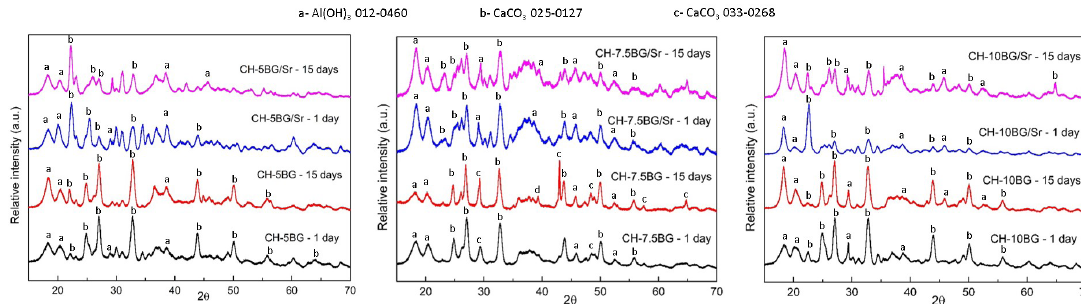
Figure 6. XRD patterns for blends based on homogeneous calcium aluminate cement (CH) containing different contents of bioactive glass (BG) and 1 wt% strontium (Sr), without or with SBF treatment for 1 and 15 days.